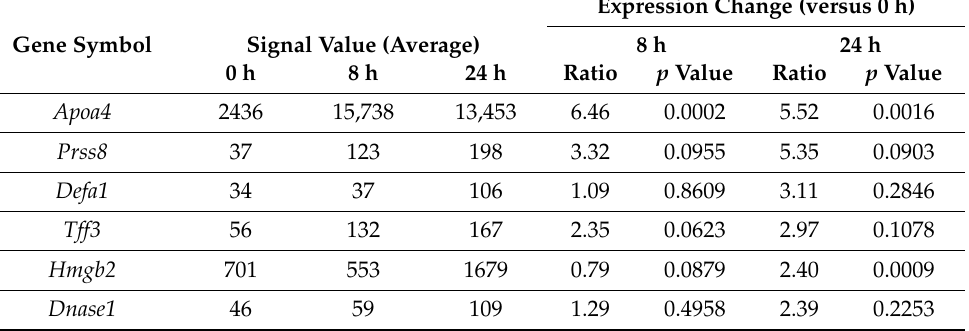
Table 1. Genes highly induced by rh-HGF in the murine liver. Signal values at each timepoint show the average obtained from 3 mice which were sacrificed at designated timepoint before or after rh-HGF administration (1.5